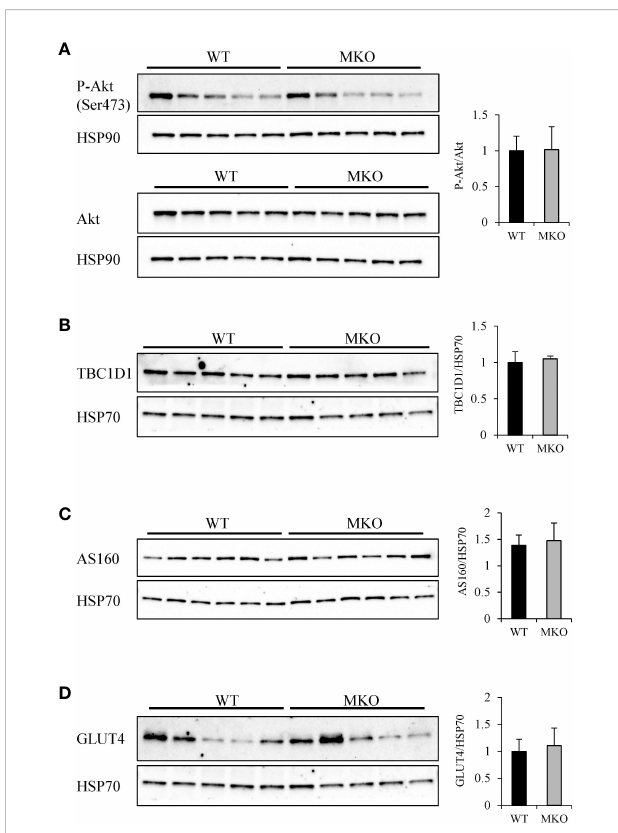
FIGURE 7 Analysis of genes regulating glucose uptake. (A) Western blot analysis of P-Akt (Ser473) (top) and Akt (bottom) expression in Arid5b WT and MKO GC. HSP90 was included as a loading control. Quantitation of normalized P-Akt to normalized total Akt is shown on the right. The expression of (B) TBC1D1, (C) AS160, and (D) GLUT4 were analyzed by Western blot in Arid5b WT and MKO GC and normalized to HSP70. Quantitation was performed, and results are expressed as the means ±